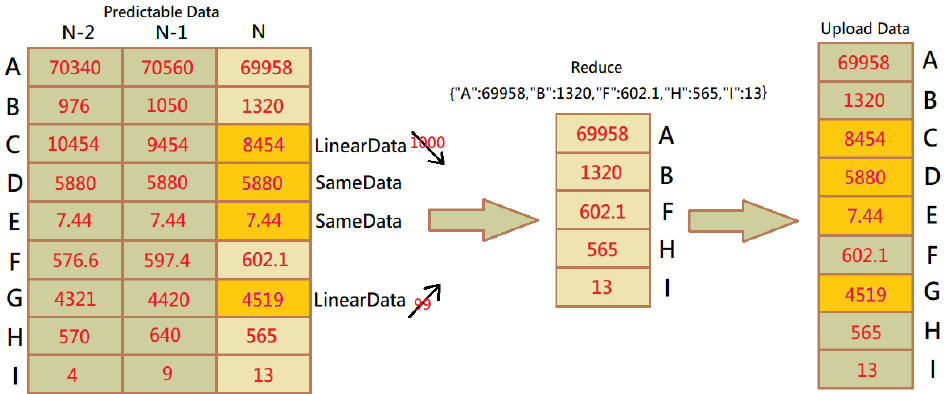
Figure 2. Reducing data transmission methods.